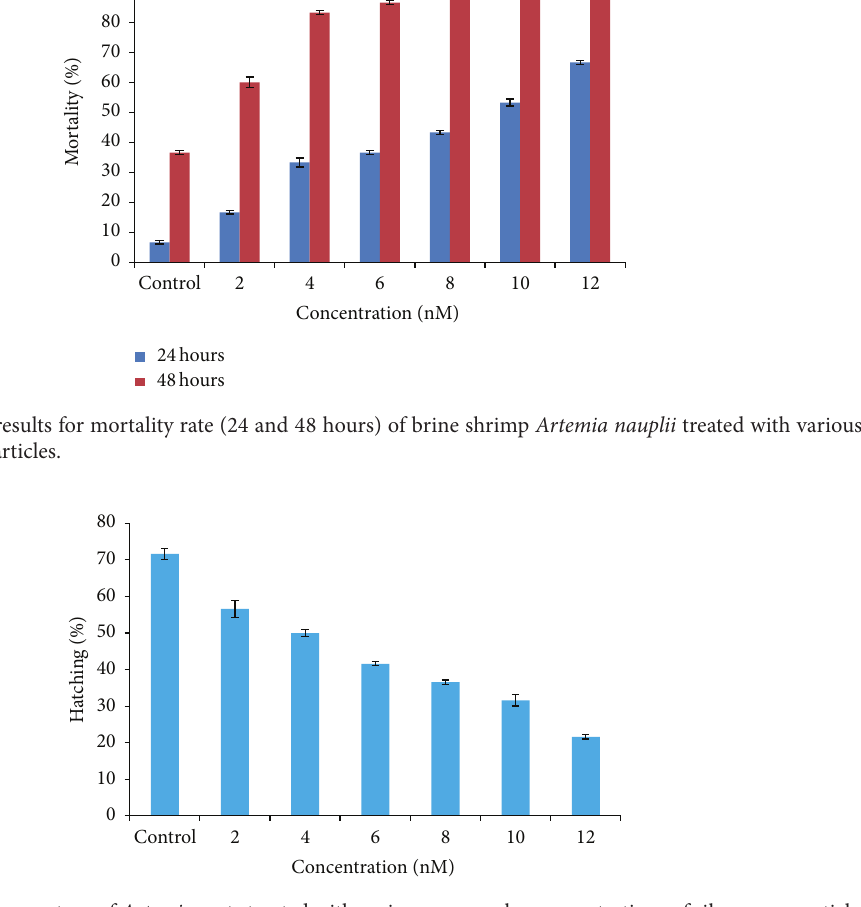
Figure 4: Hatching percentage of Artemia cysts treated with various nanomolar concentrations of silver